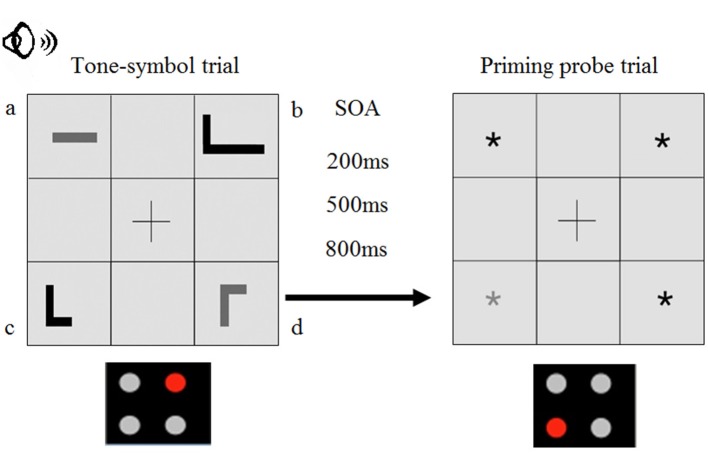
Sample trial display, including a tone-symbol trial followed by a priming probe trial. For example, in this trial, the target could be the low long black symbol (b), with the participant hearing the low long black (160 Hz 1000 ms sine wave) tone. For the first 400 ms, this tone would also match the low short black symbol (i.e., the competitor, c). Shapes in the top left and bottom right quadrants contain symbols that are easily ruled out based on pitch and timbre (a,d). Since the gray asterisk appears in the location previously occupied by the competitor (c), the priming probe is a negative priming trial. Participants identified the gray asterisk from among the black asterisks.